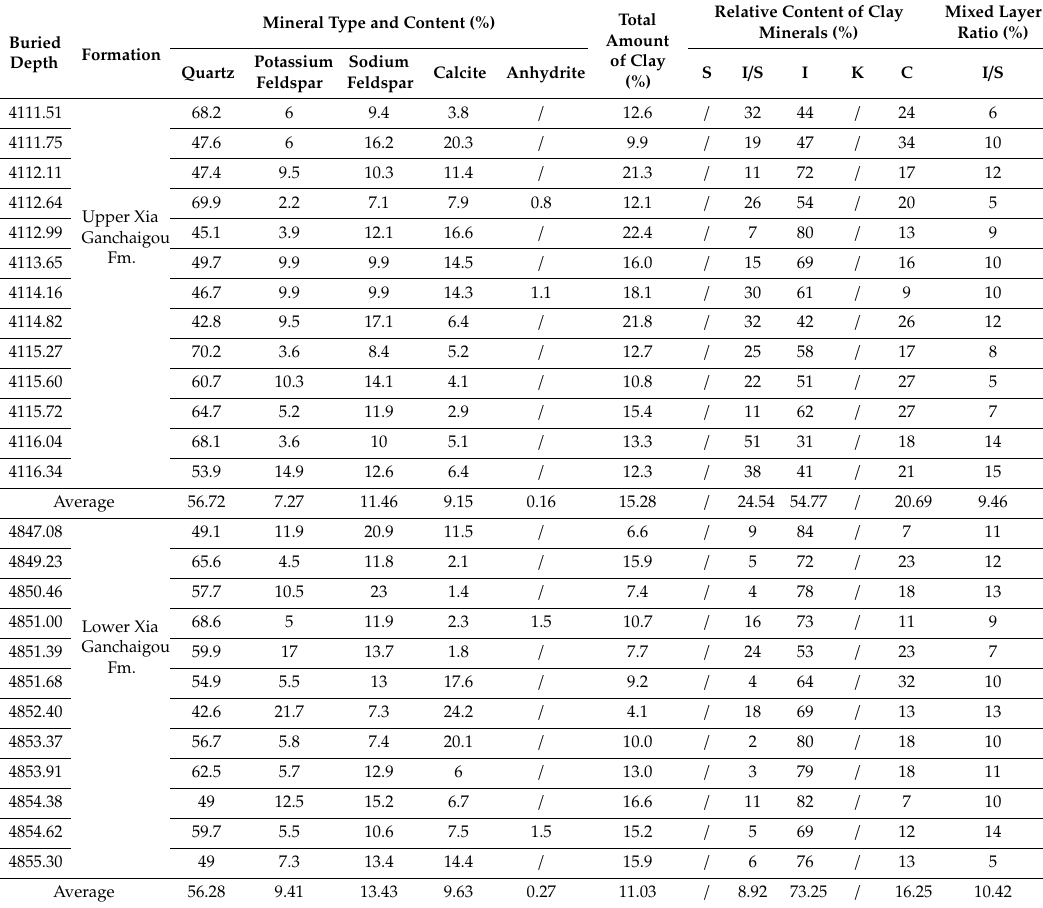
Table 1. X-ray Di ff raction Results of Whole Rock and Clay Mineralogy of the Xiaganchaigou Formation.